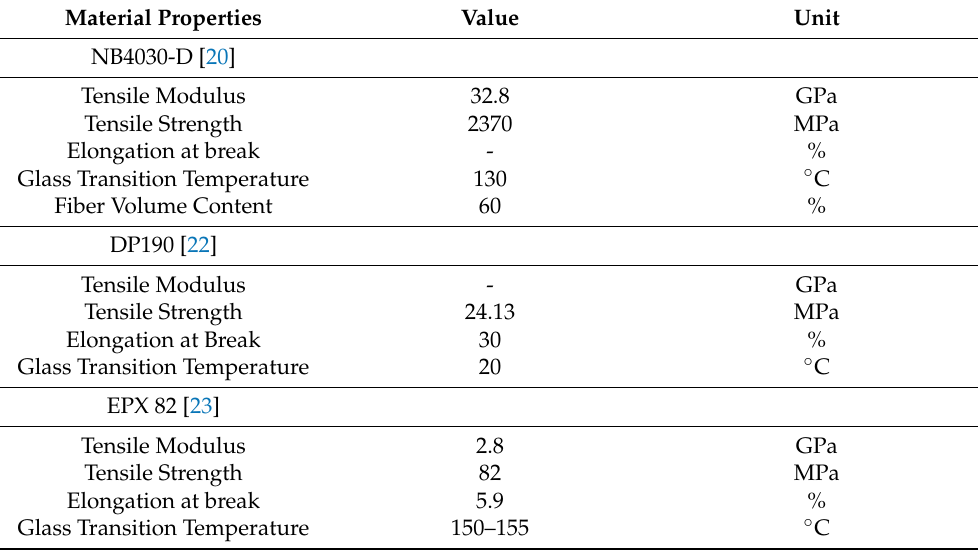
Table 1. Properties for materials used in this study.